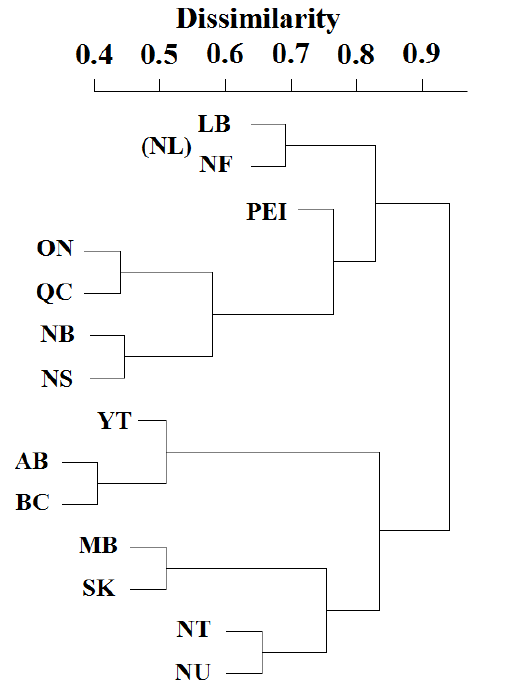
Figure 3. Cluster analysis of Plecoptera assemblages for Canadian provinces. For meaning of province abbreviations, see Figure 2 legend. The assemblages of Newfoundland (NF) and Labrador (LB) were kept separate in this